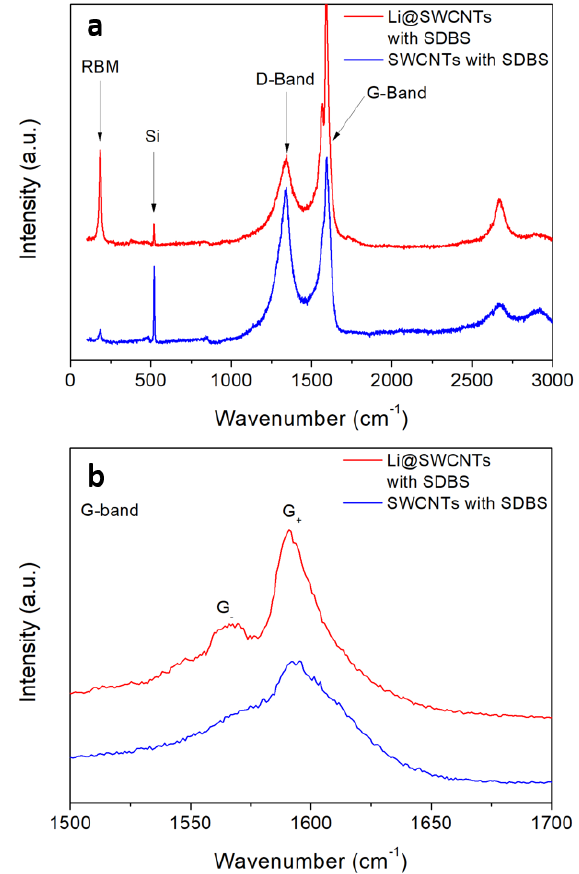
Figure 3. Raman spectra of undoped SWCNT and Li@SWCNTs dispersed with SDBS and deposited on silicon. ( a ) Overview spectra ( b ) Detailed view of the